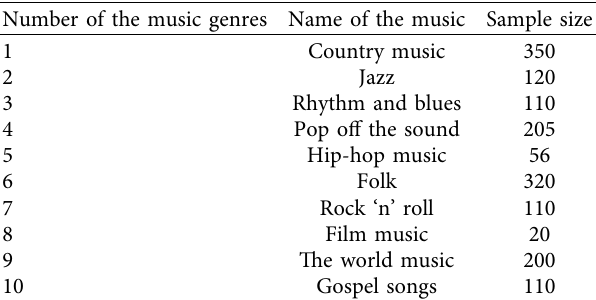
Figure 5: The proportion of the number of tracks of each song. Table 1: Sample distribution of 10 types of music.